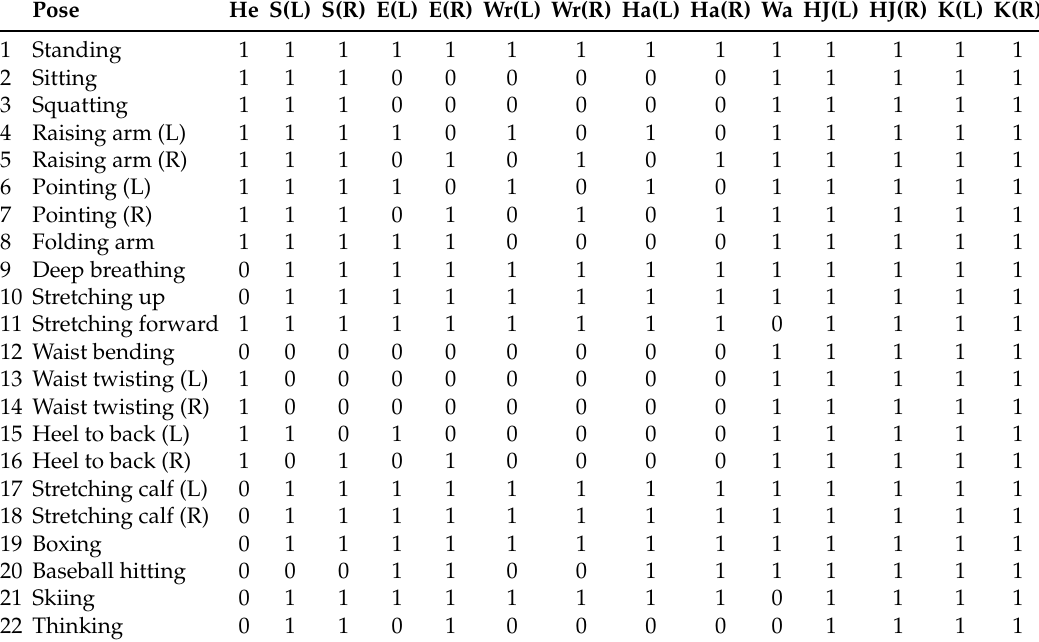
Table 4. Attributes’